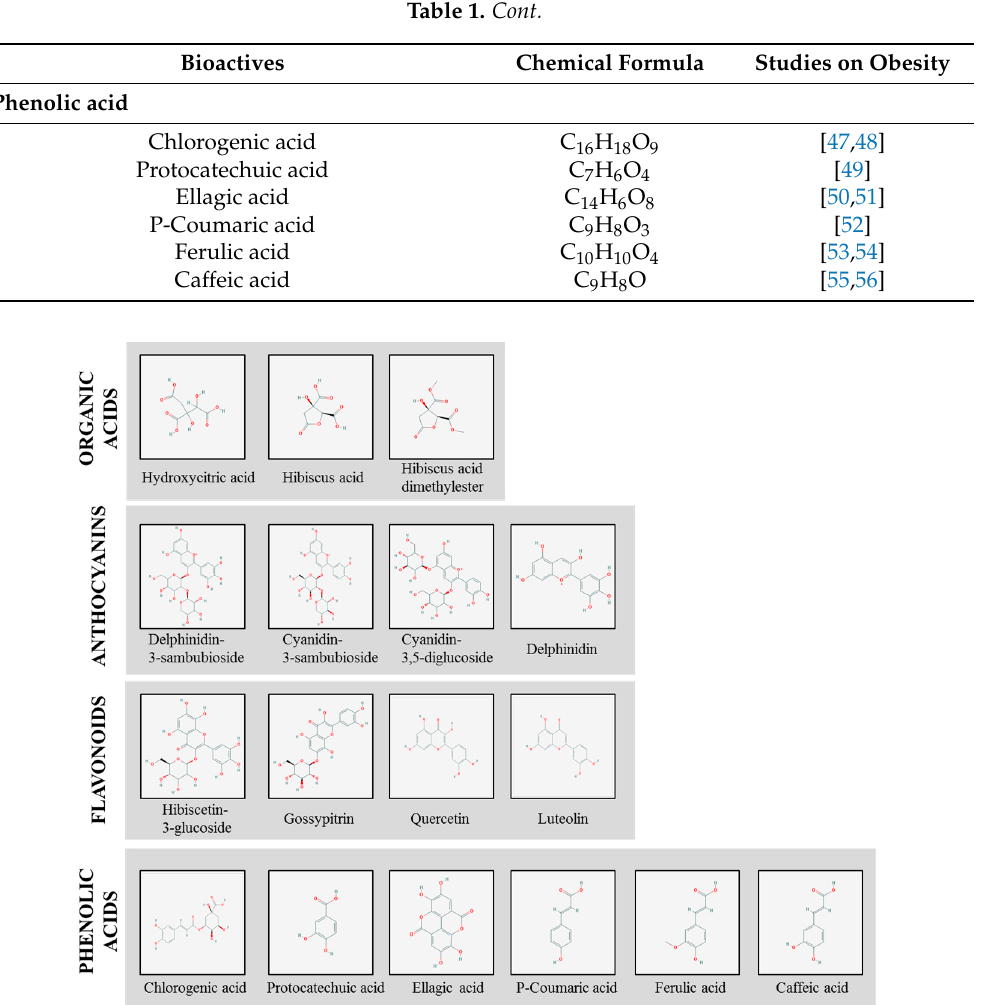
Figure 1. Chemical structural formula of major bioactive compounds in H. sabdariffa.